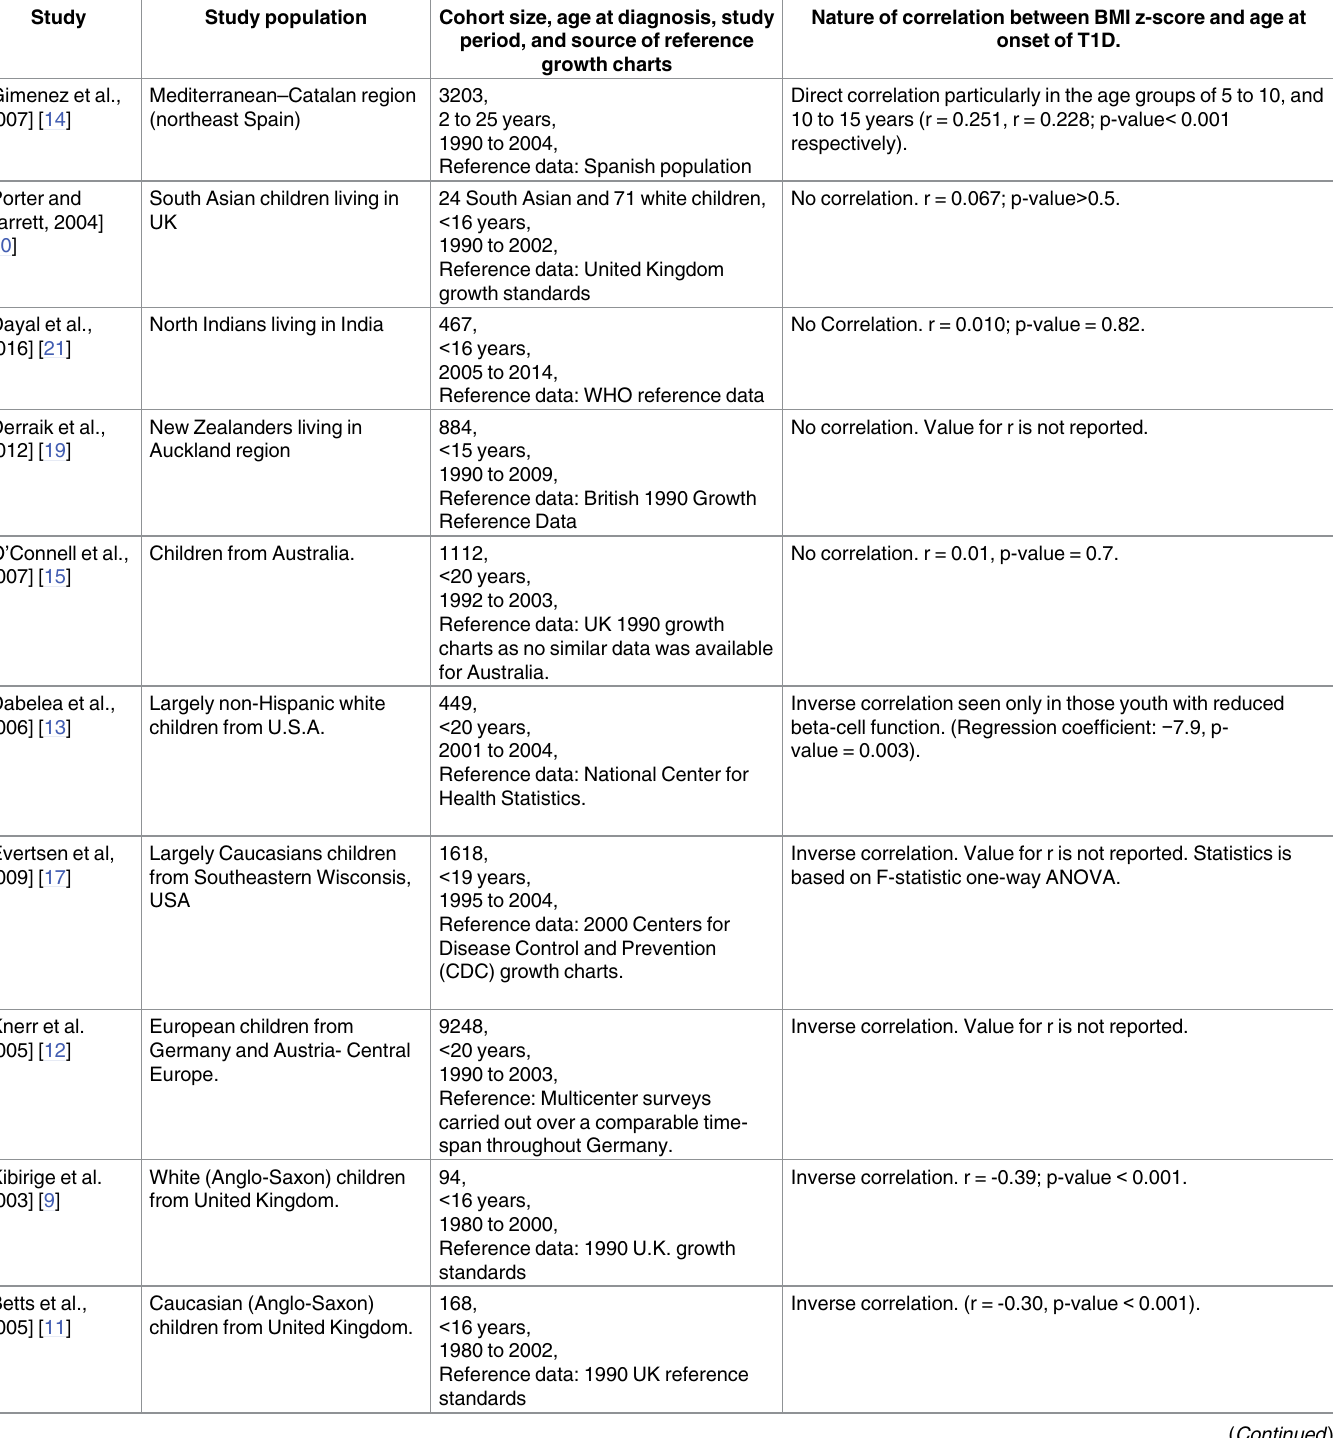
Table 1. Summaryof findings from previous studies on association between age- and sex-adjusted BMI z-scoresand age at onset of T1D in vari- ous populations.